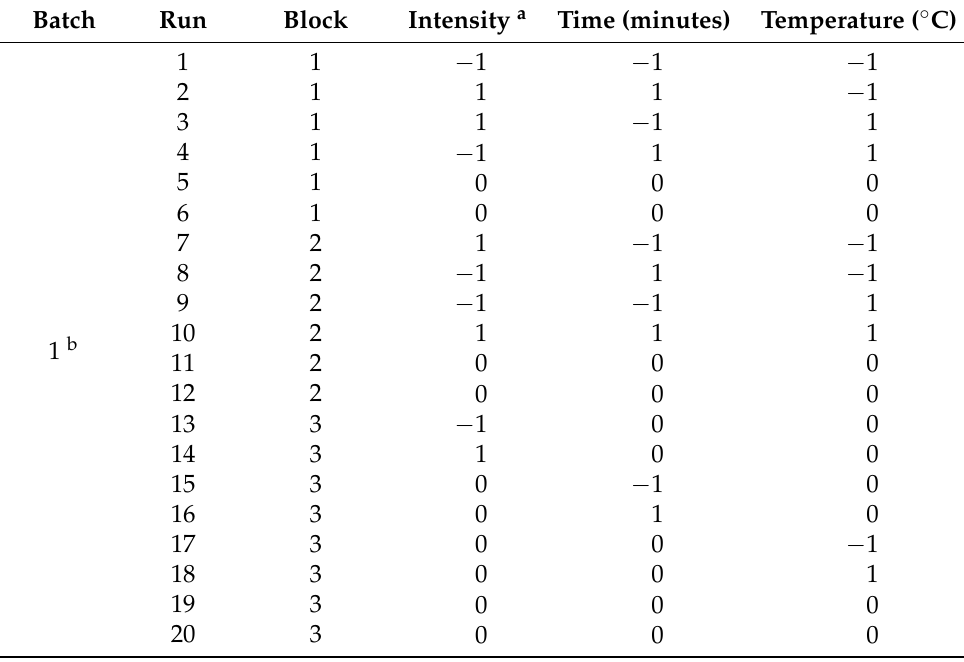
Table 1. Design of experiments with coded variable levels. Batch Run Block Intensity a Time (minutes) Temperature ( ◦